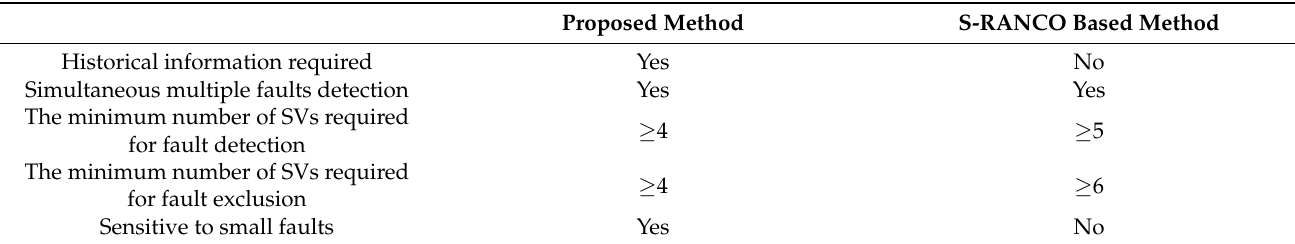
Table 4. Comparison between the proposed method and S-RANCO based